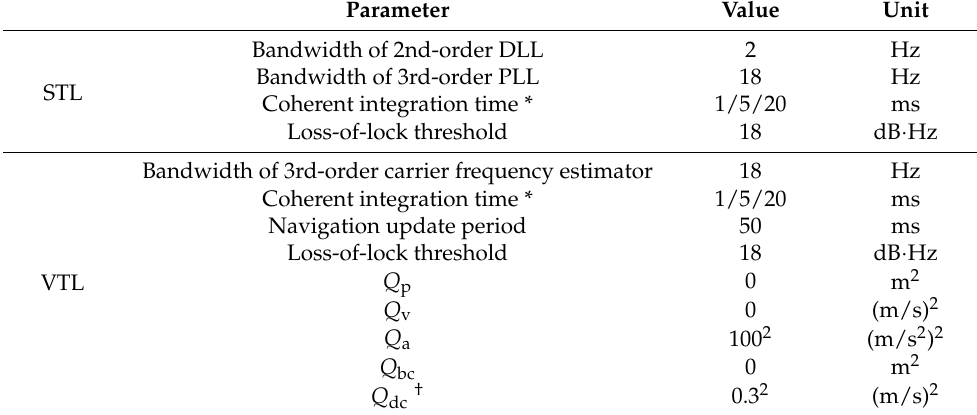
Table 3. Receiver parameters